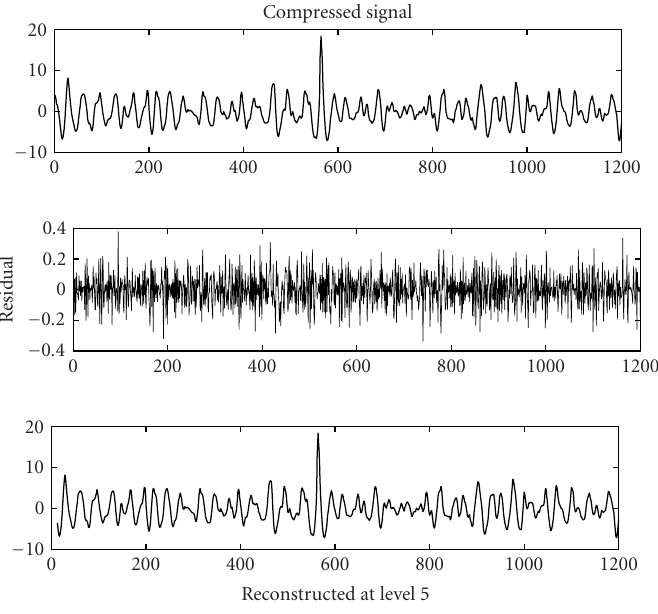
Figure 3.4. Compression with global thresholding.